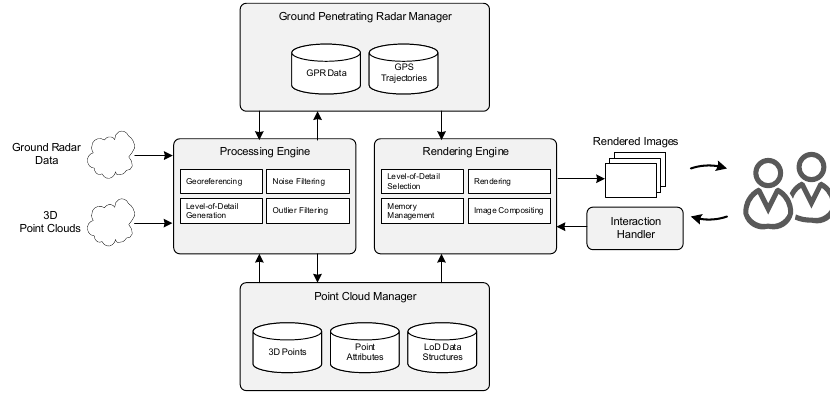
Figure 3. System overview showing data flow integration, processing, visualization, and interaction